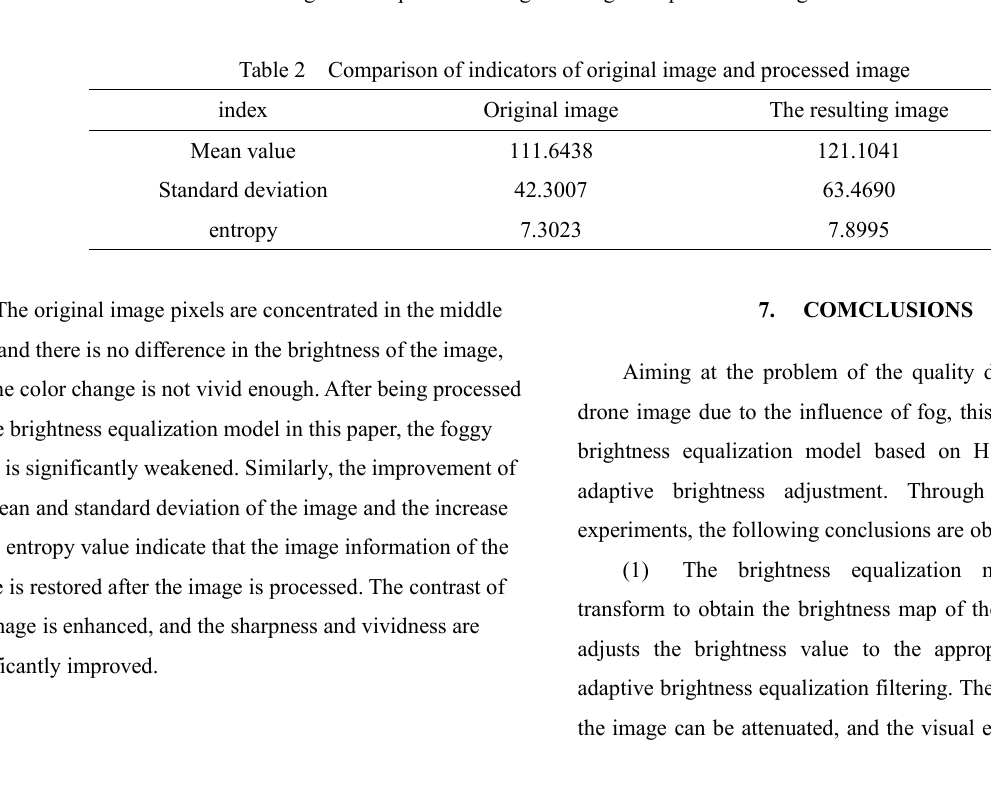
Fig.4 Comparison of original image and processed image